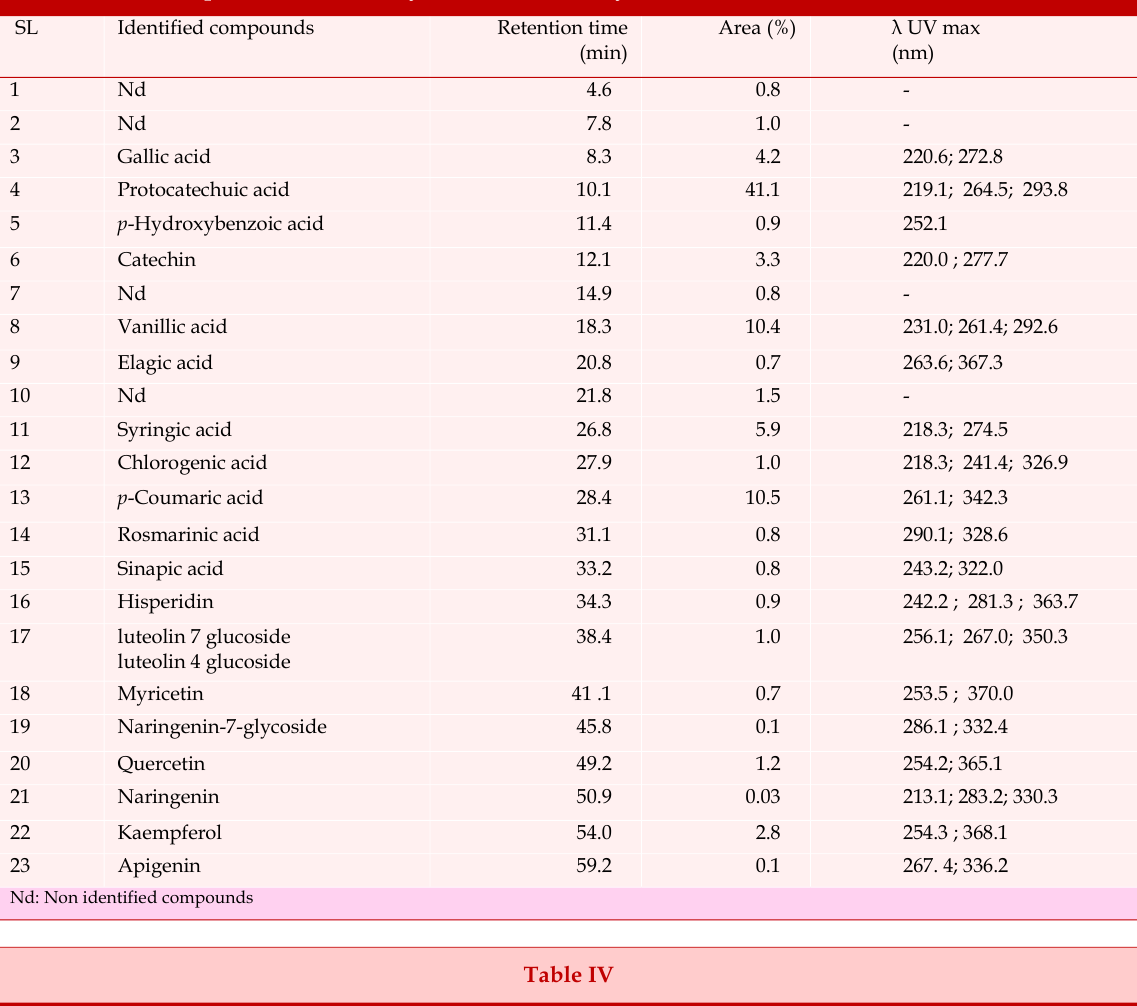
Phenolic compounds identified by HPLC-DAD in a hydromethanolic extract of P. coulteri needles